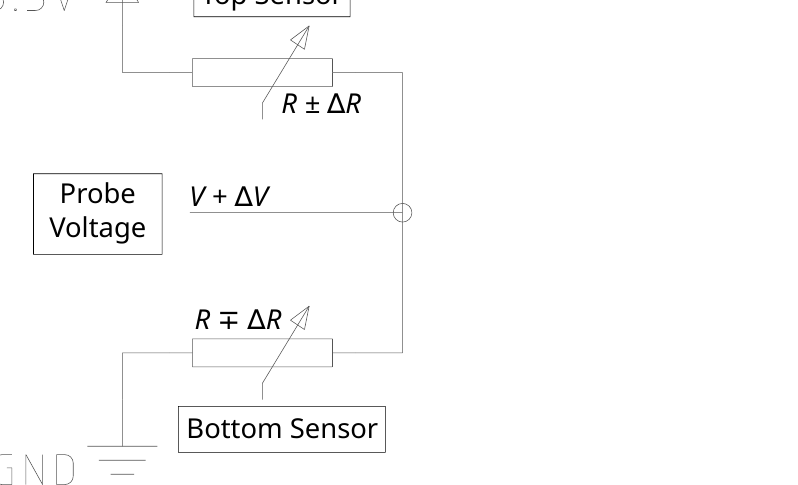
Figure 5. Schematic drawing representing a pair of strain gauges connected in a voltage divider circuit on the 3-DOF sensor. Ideally, the two gauges experience equal and opposite resistance (as shown) resulting in the voltage reading at the probe location having a “doubling” effect compared to only a single-gauge